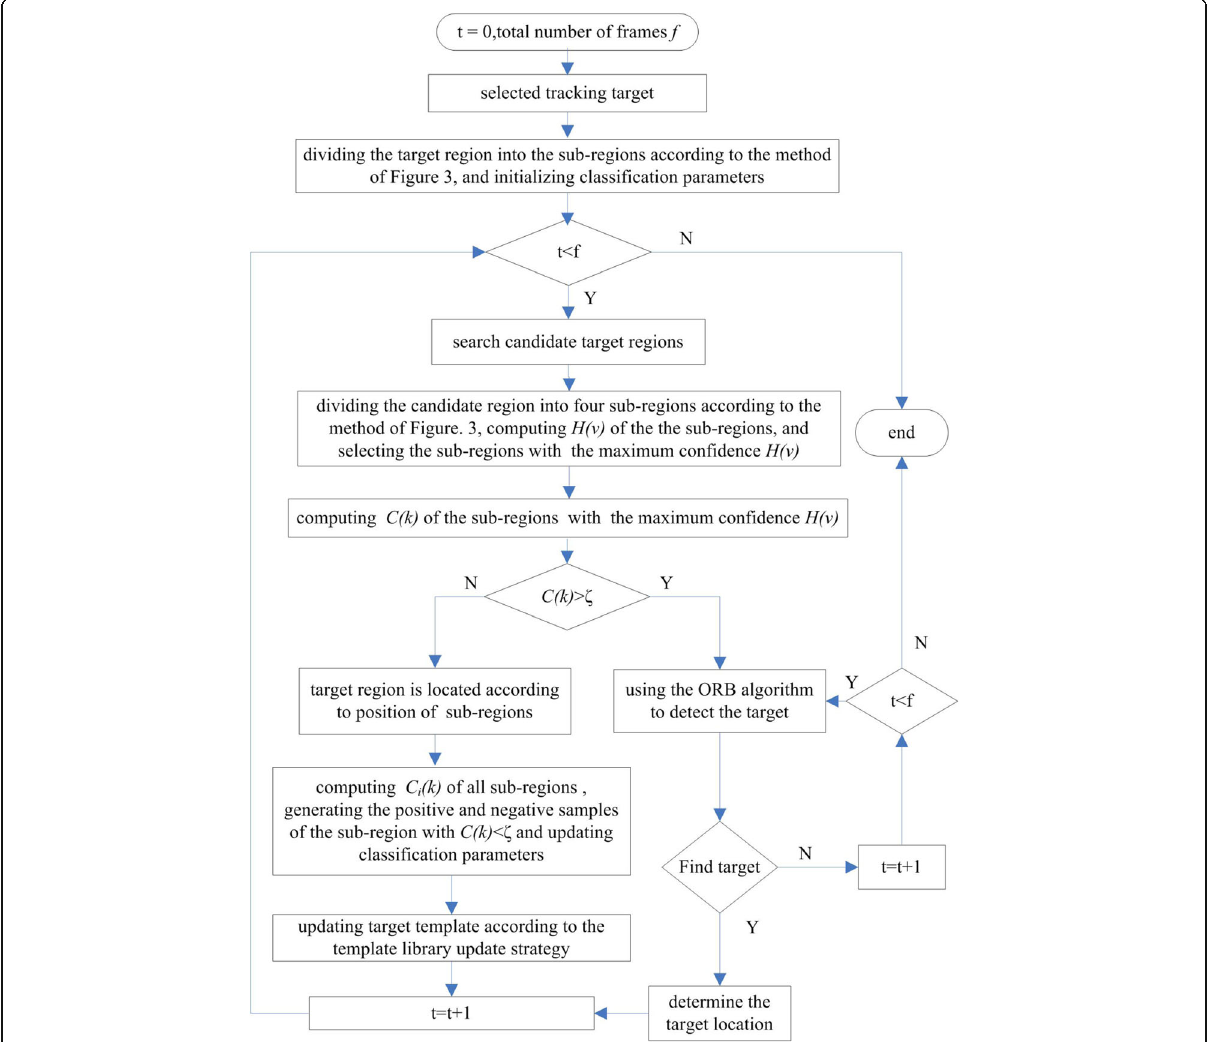
Fig. 11 Flow chart of the improved